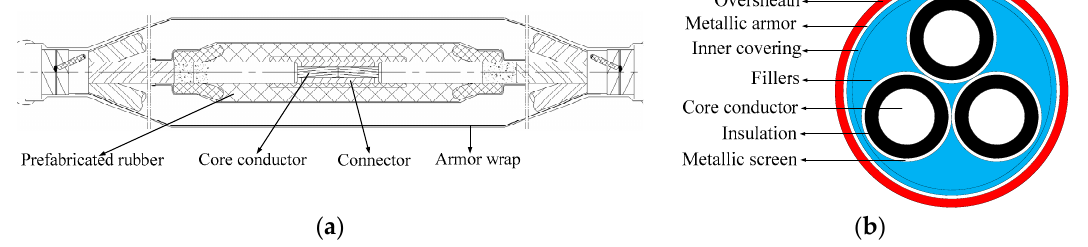
Figure 1. The schematic diagram of the three-core cable and joint. ( a ) Cable joint; ( b ) Cable.